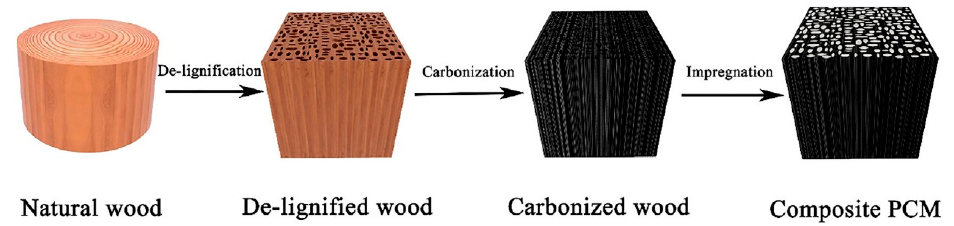
Figure 3. Schematic diagram of preparing PCM/carbonized wood composite (reprinted with permission from Reference